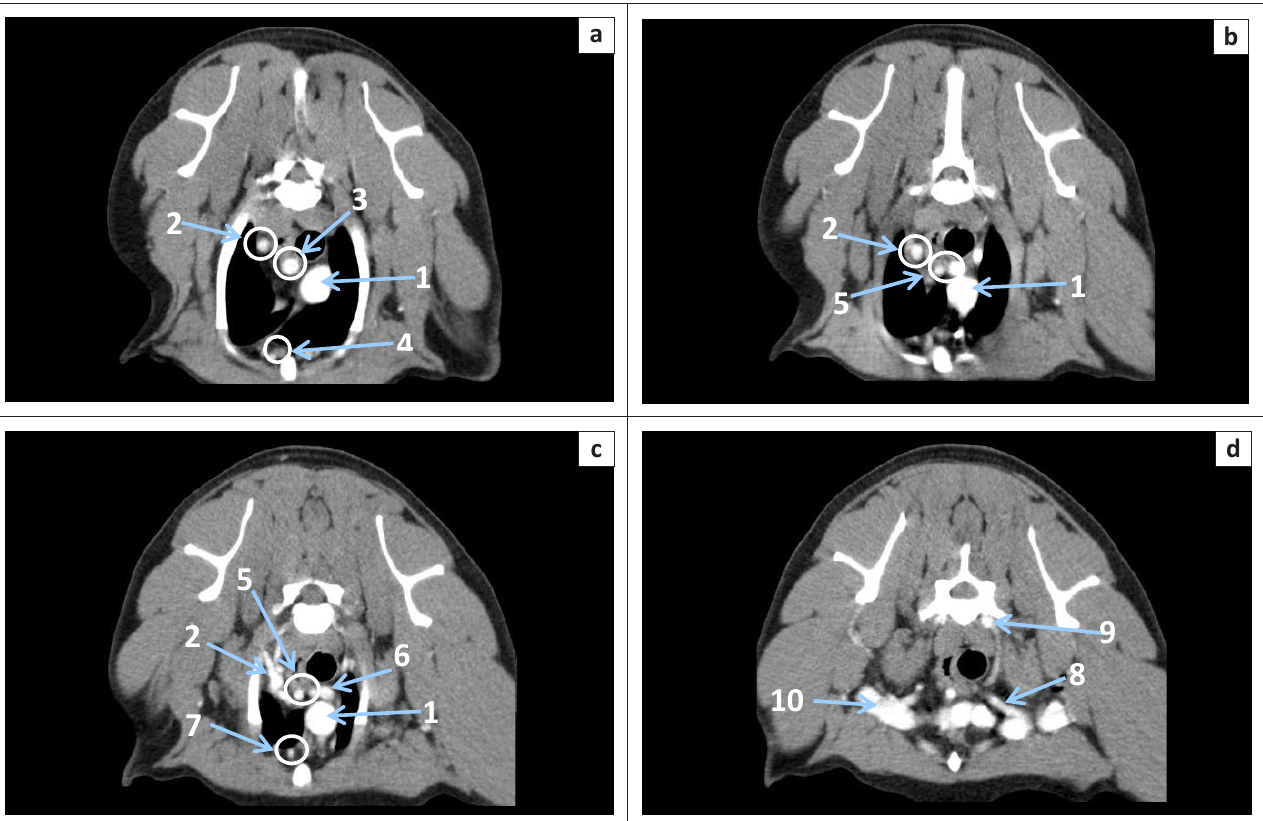
1, cranial vena cava; 2, left subclavian artery; 3, brachiocephalic trunk; 4, internal thoracic vein; 5, left and right common carotid arteries; 6, right subclavian artery; 7, internal thoracic artery; 8, costocervical trunk; 9, vertebral artery; 10, confluence of the axillary vein into the brachiocephalic vein. Left of the dog is to the left of the image. Window width, 400; window length, 40. FIGURE 2: Transverse images of dog 5 during the arterial phase for the BT technique showing attenuation in the smaller cranial thoracic vessels. Images taken from the level of the aortic bulb (a) moving cranially to (d).